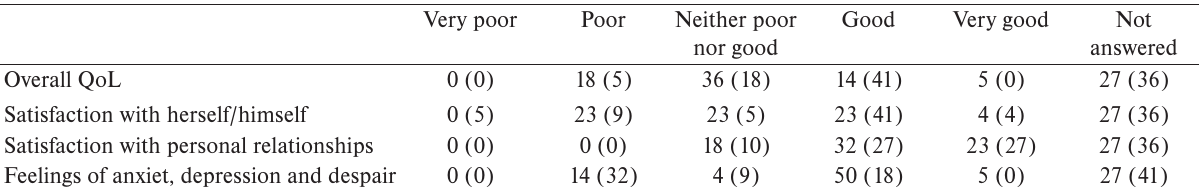
Table 1. Evaluation of quality of life in patients undergoing total laryngectomy (WHOQOL-BREF).